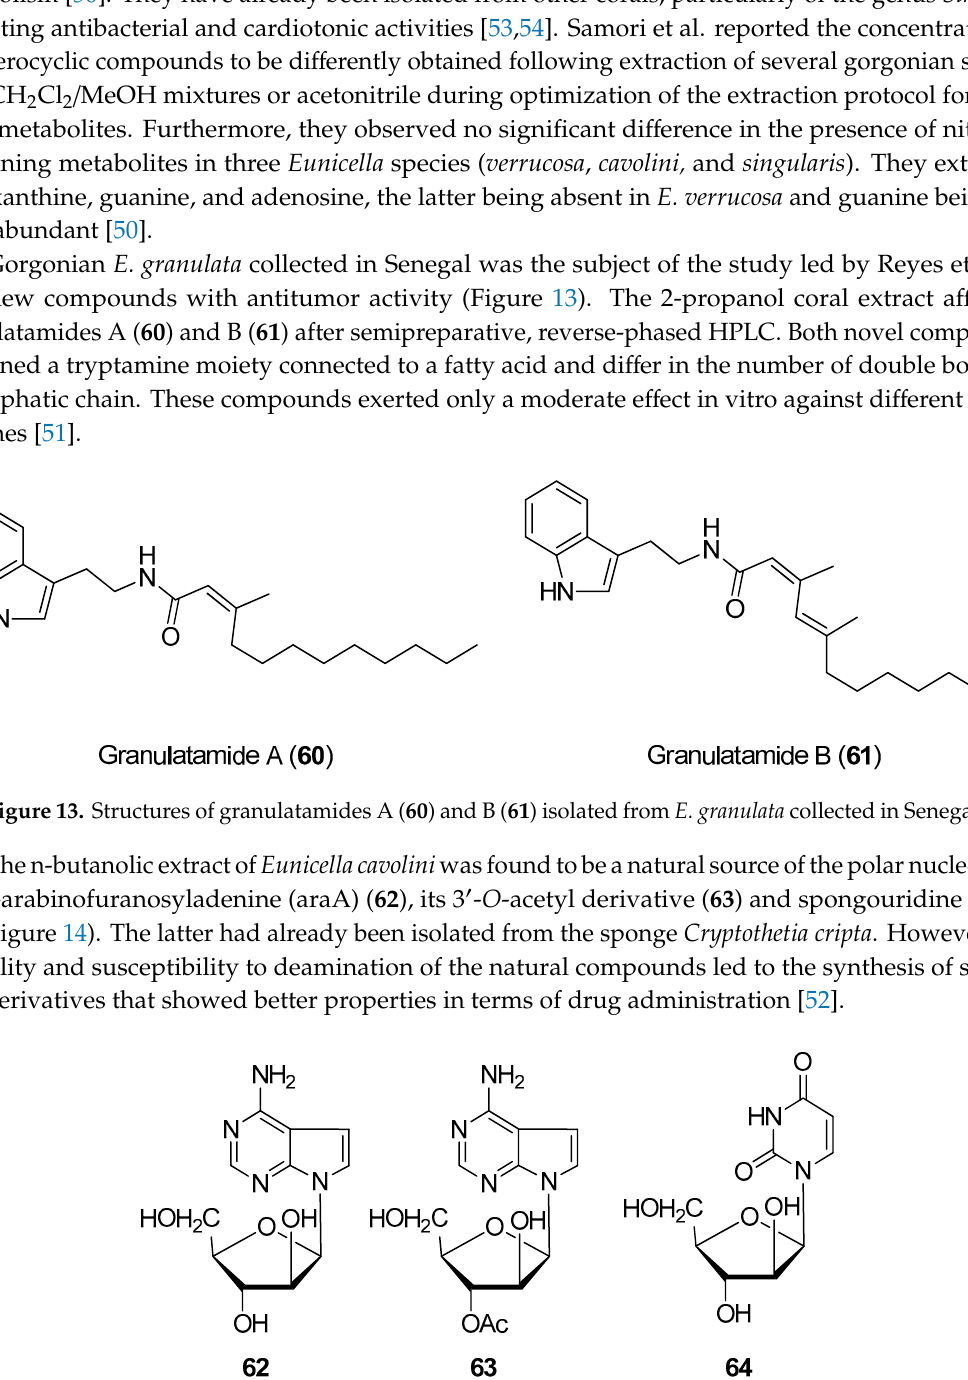
Figure 14. Structures of nucleosides 9- β - D -arabinofuranosyladenine (araA) ( 62 ), its 3 ′ - O -acetyl derivative ( 63 ), and spongouridine (araU) ( 64 ) isolated from Eunicella cavolini .